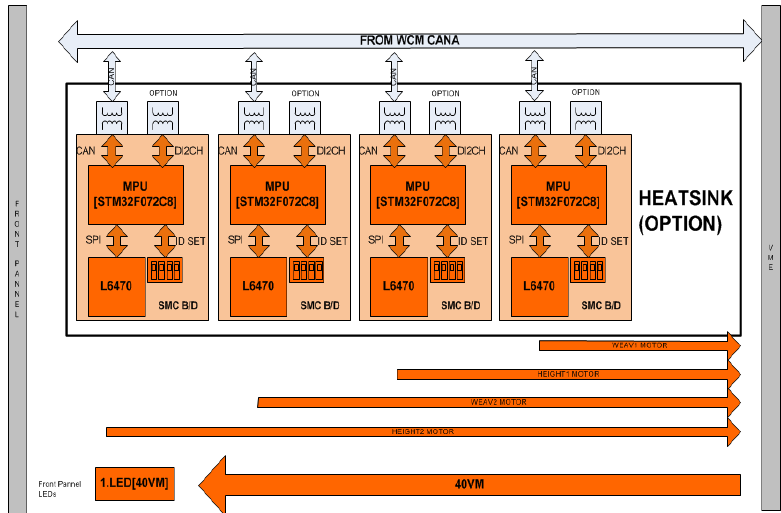
Figure 6. Step motor module ( SMM) board block diagram.